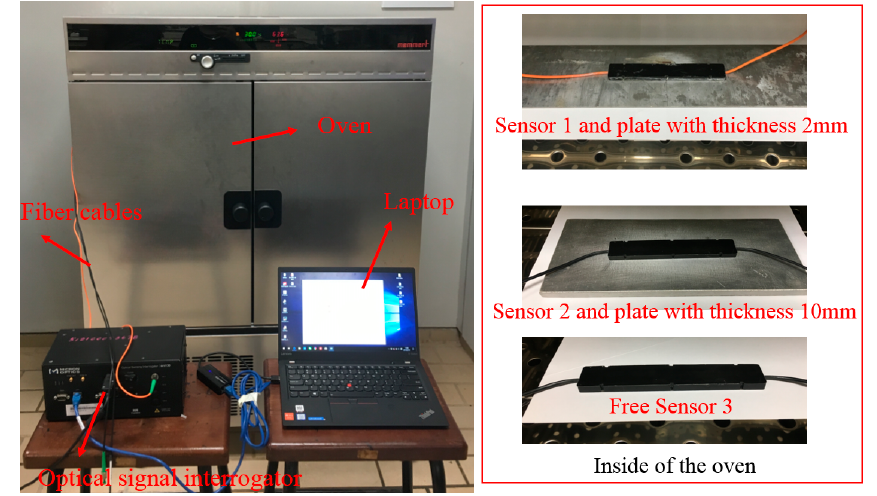
Figure 12. Experimental design for the calibration of temperature variations.